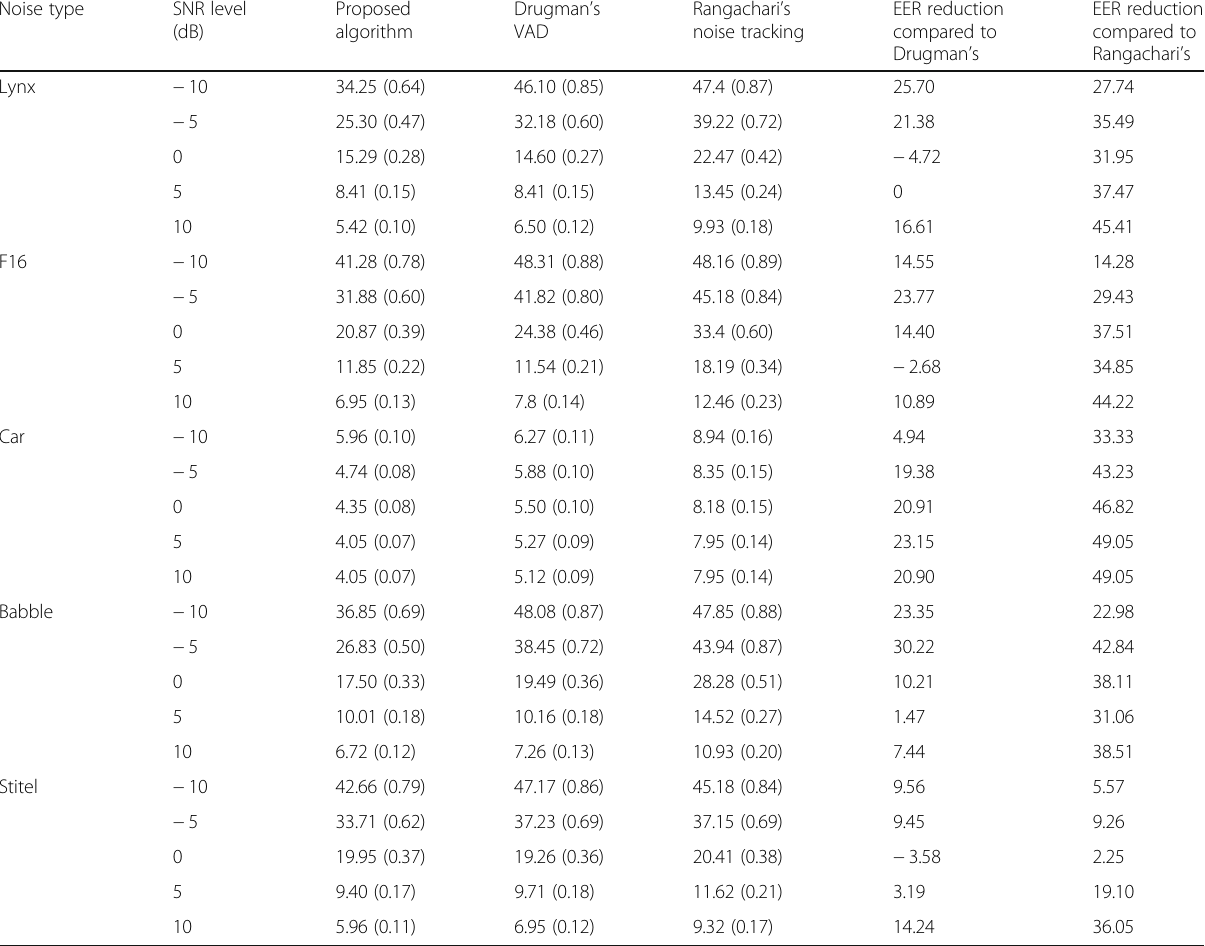
Table 1 Male speaker verification results of GMM-UBM method in terms of percent EER (minDCF) for the proposed algorithm, Drugman ’ s VAD method [27], and Rangachari ’ s noise tracking method [21]. The last columns show the relative percent EER reduction rates compared to Drugman ’ s VAD and Rangachari ’ s method, respectively Noise type SNR level Proposed (dB)